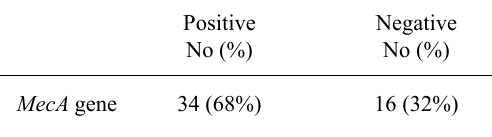
table 5. Percentage of antibiotic